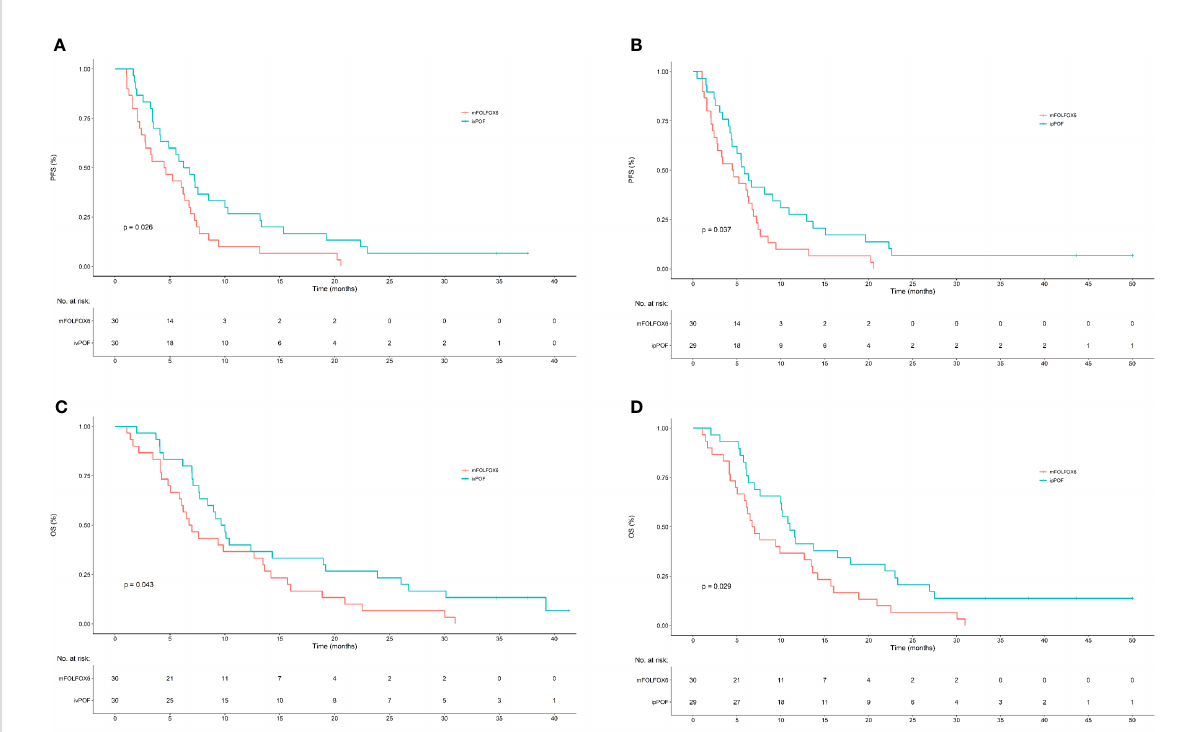
FIGURE 2 Kaplan – Meier estimates of PFS and OS for ivPOF or ipPOF vs. mFOLFOX6. (A) Median PFS (months) was 6.52 (95% CI: 4.13 – 10.27) in the ivPOF group and 4.55 (95% CI: 2.73 – 6.87) in the mFOLFOX6 group (HR, 0.56; 95% CI: 0.33 – 0.94; p = 0.026). (B) Median PFS (months) was 5.83 (95% CI: 4.43 – 10.93) in the ipPOF group and 4.55 (95% CI: 2.73 – 6.87) in the mFOLFOX6 group (HR, 0.56; 95% CI: 0.33 – 0.96; p = 0.037). (C) Median OS (months) was 9.83 (95% CI: 7.70 – 19.2) in the ivPOF group and 6.87 (95% CI: 5.83 – 13.6) in the mFOLFOX6 group (HR, 0.59; 95% CI: 0.35 –